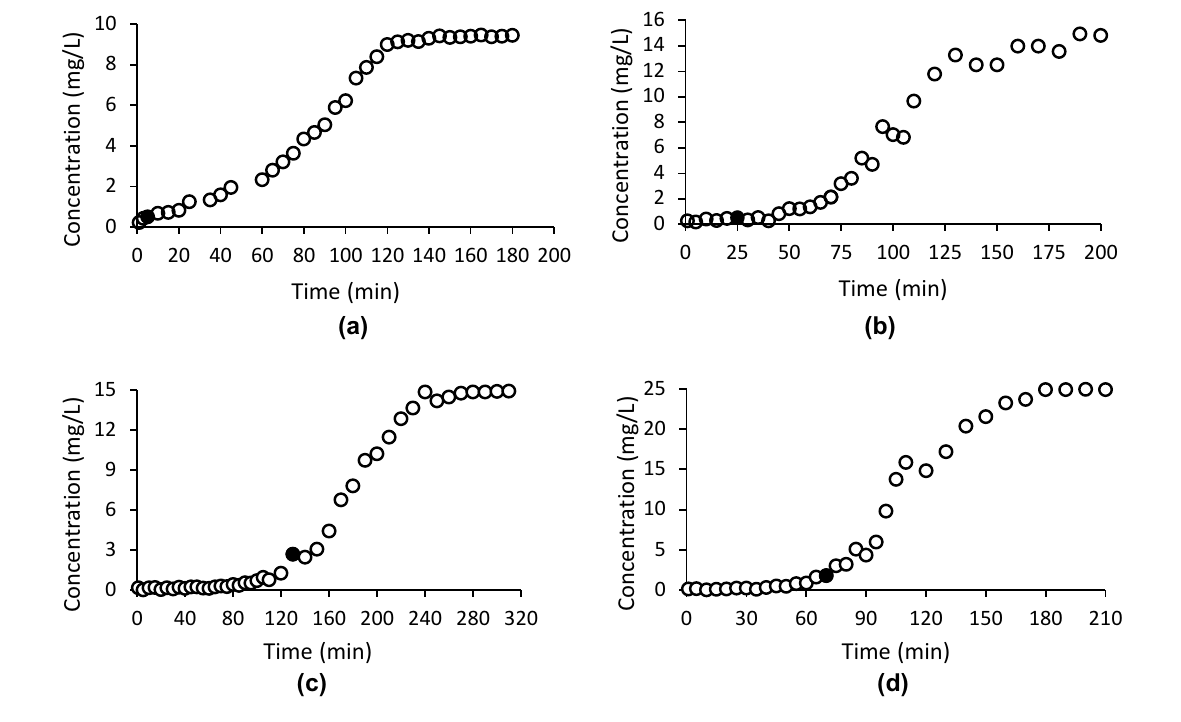
Fig. 2 Breakthrough curves of Cr (VI) and Ni (II) on natural sugar cane bagasse at different experimental conditions: a Co (Cr) = 10 mg/L and m = 1.5 g; b Co (Cr) = 15 mg/L and m = 1.5 g; c Co (Ni) = 15 mg/L and m = 1.5 g; d Co (Ni) = 25 mg/L and m = 1.5 g.